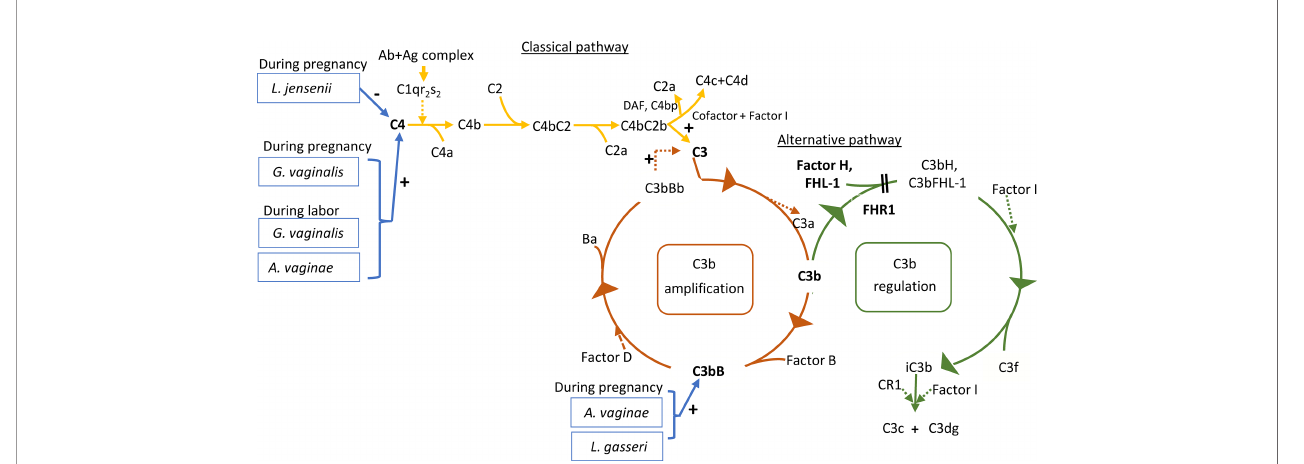
FIGURE 7 | Roles of the studied proteins in complement activation, ampli fi cation and regulation. The classical pathway is activated primarily by immune complexes. When antibody binds antigen, a subtle conformational change occurs that renders the antibody molecule capable of interacting with C1q. In circulation, C1q associates with a complex of two C1r and two C1s serine proteases to form a C1qC1r 2 s 2 pentamer commonly known as the C1 complex. Activated C1s subsequently cleaves C4 to generate C4a (released to circulation) and C4b fragments. C4b is highly reactive and binds covalently to nearby surfaces. C4b recruits C2, which in turn is cleaved by C1s to the C2a fragment (released to circulation) and C2b, which is a serine protease and stays associated with C4b. The C4bC2b protease then activates C3. In the alternative pathway, there is a continuous low-grade hydrolysis and activation of C3. By binding factor B and its cleavage by factor D, an alternative pathway C3 convertase (C3bBb) is formed. It cleaves multiple C3 molecules to C3b. By formation of new C3 convertases an ampli fi cation loop is generated. Subsequent cleavage of C5 into C5a causes in fl ammation and C5b initiates the development of the membrane attack complex (MAC). Regulators of this activation include Factor I, which degrades C3b and C4b, Factor H, which acts as a cofactor for Factor I for C3b cleavage and as a promoter of C3 convertase decay. The vaginal bacteria Atopobium vaginae, L. gasseri, G.vaginalis and L. jensenii were found to correlate to activation of the classical and alternative pathways. Enzymatic activity is marked by a dashed line. The measured components are indicated in